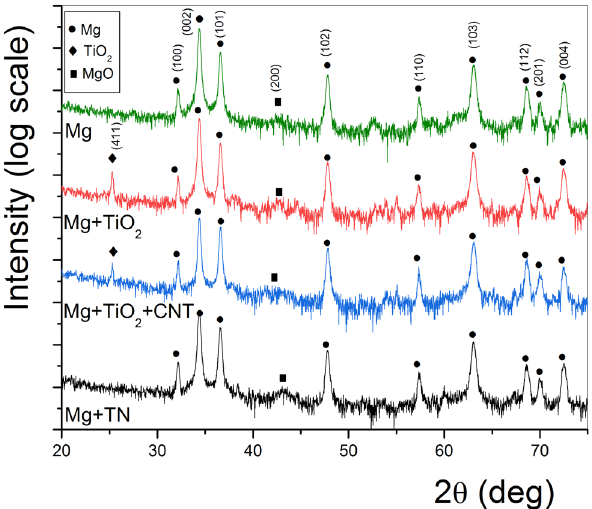
Figure 3: XRD patterns of the catalyzed Mg - based